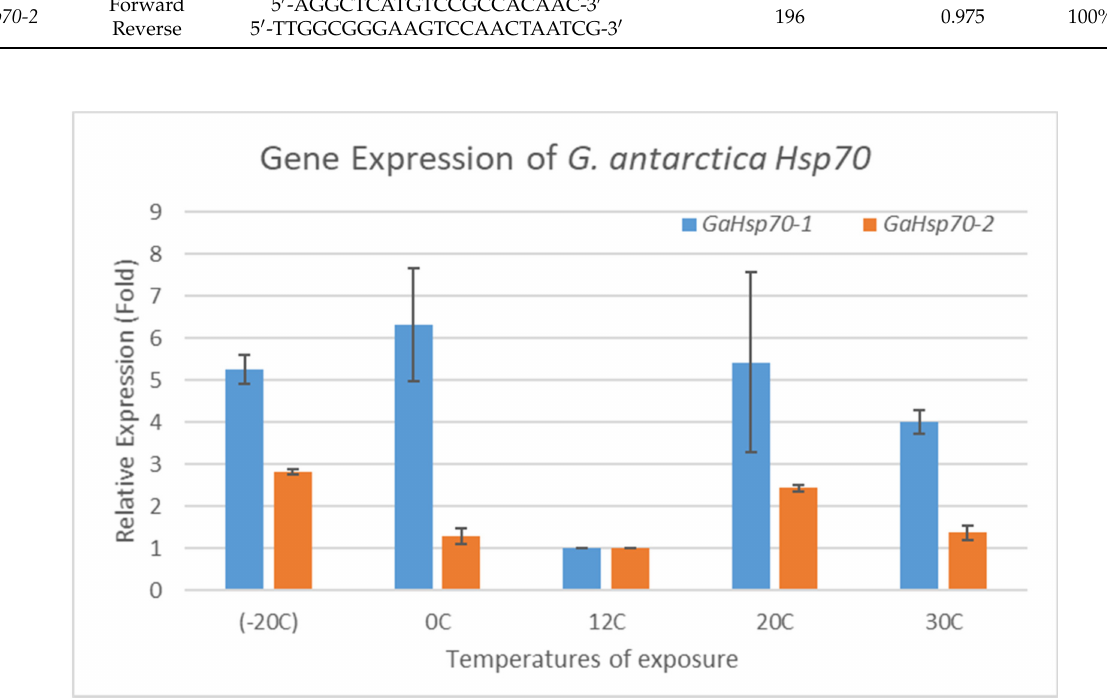
Figure 2. Hsp70 mRNA expression in G. antarctica PI12. GaHsp70-1 and GaHsp70-2 levels were measured in cells exposed to temperatures of − 20, 0, 20, and 30 ◦ C for 6 h and normalized to 18 S (reference gene) levels. The mRNA expression at 12 ◦ C was set to 1, and other values were normalized against this value. The data are representative of three trials with standard deviations of the mean, and statistical significance was assessed using a two-way ANOVA